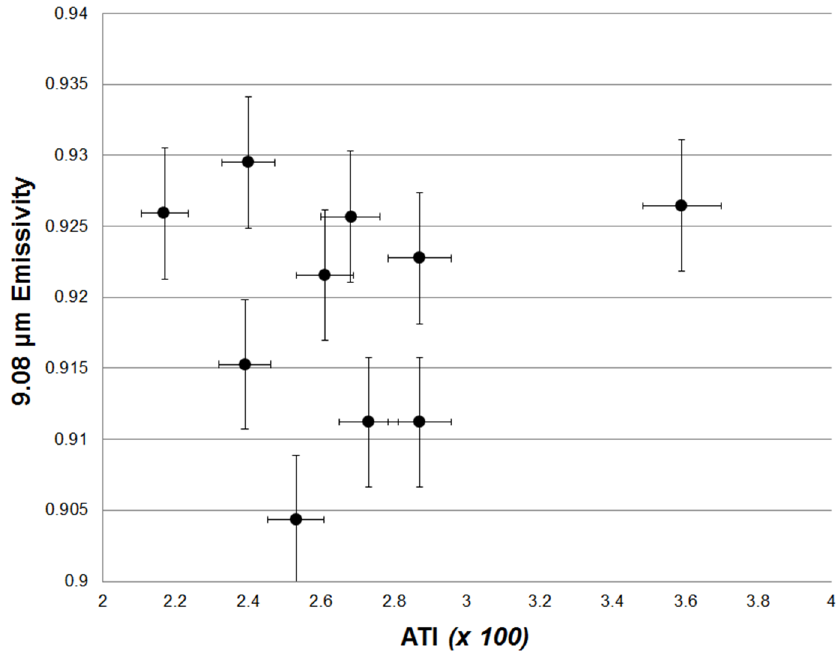
Figure 10. ASTER TIR band 12 (9.1 micrometers) surface emissivity (Level 2, AST_05) versus ATI for various the field sites. The lack of correlation is a direct result of very similar composition (pumiceous rhyolite lava and air fall pumice) reflected in the emissivity with very different particle sizes (pyroclastic air fall to blocks) reflected in the ATI. Error bars denote the standard error associated with the AST_05 product and the composite error in the derived ATI.